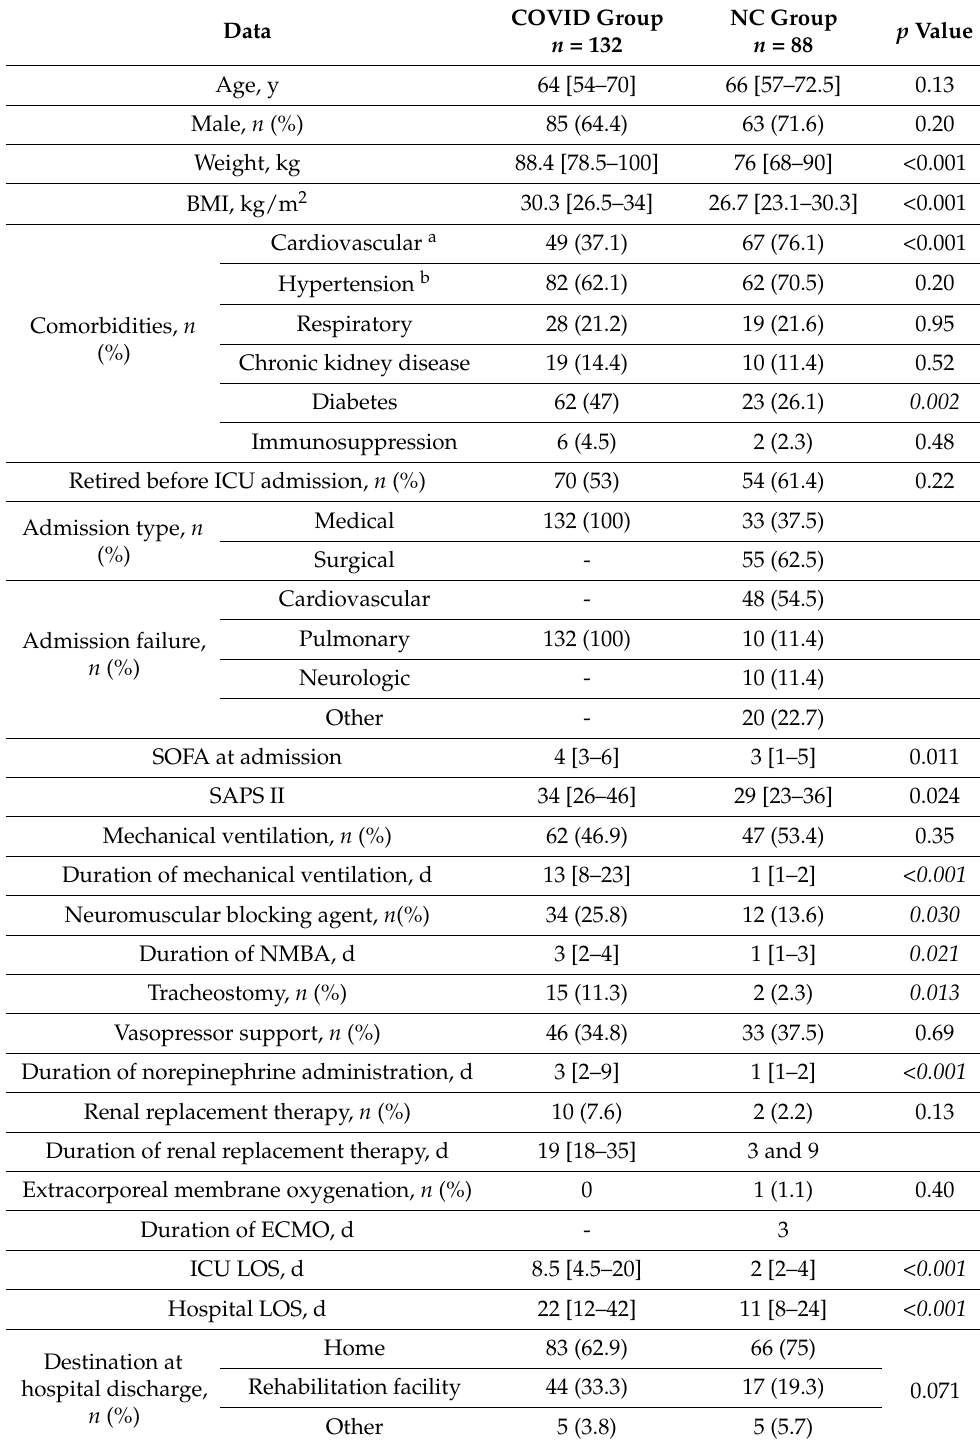
Table 1. Demographics in the COVID and NC